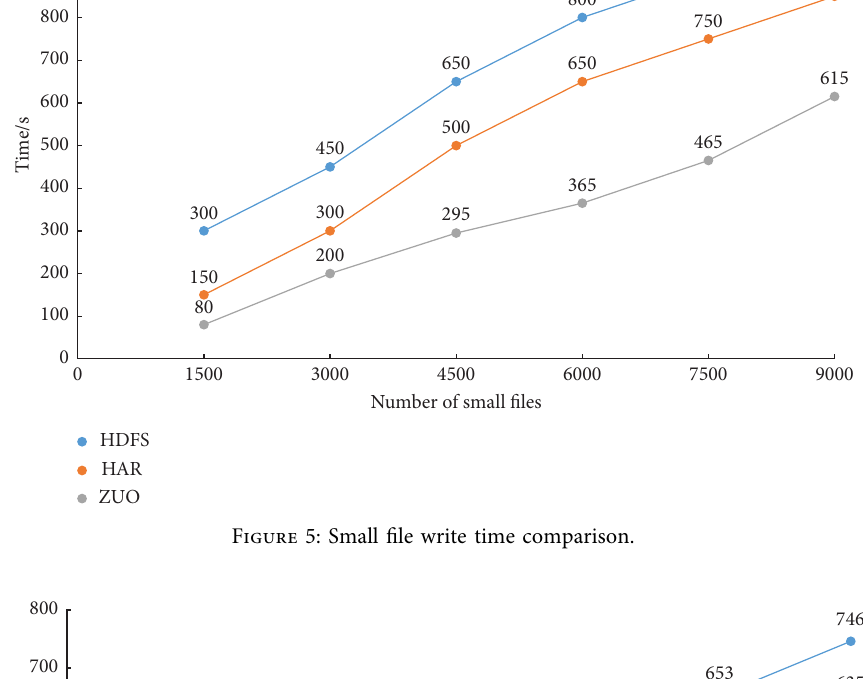
Figure 5: Small fle write time comparison.